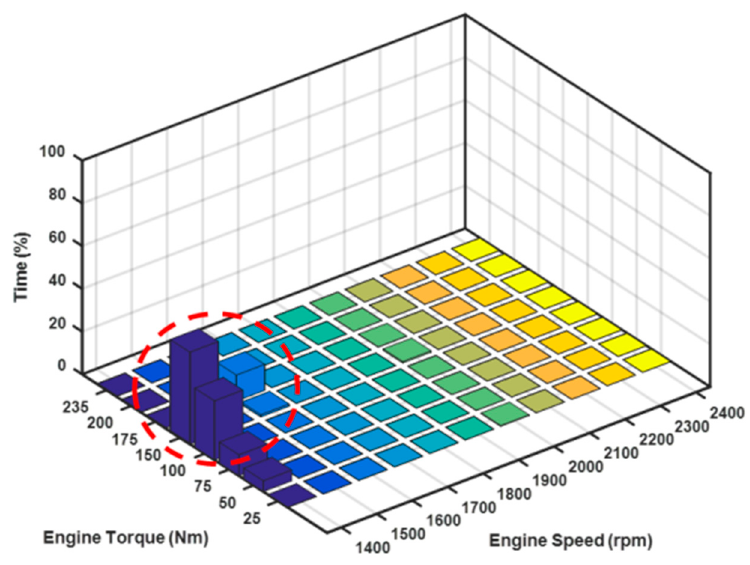
Figure 18. Engine operating time in highway driving cycle with ECMS optimization.